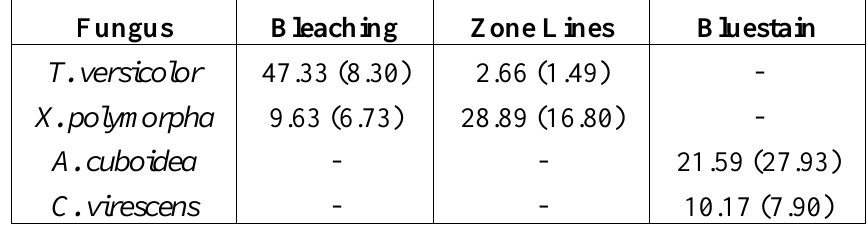
Table 1. Mean percent external spalting area for four fungi. Numbers in parenthesis indicate standard deviation. N=5